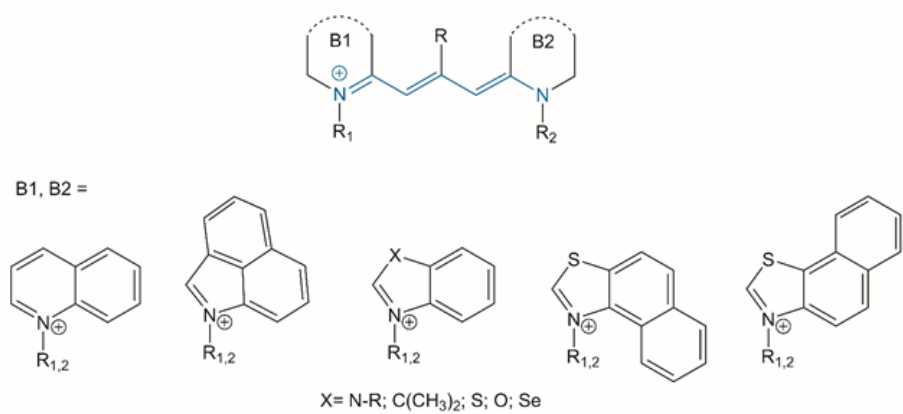
Figure 1. Generalized structure of trimethine cyanine dyes. Where R, R 1 , and R 2 are substituents (R is a meso ‐ (or 9 ‐ ) substituent; for meso ‐ unsub ‐ stituted dyes R = H), and X is a heteroatom.